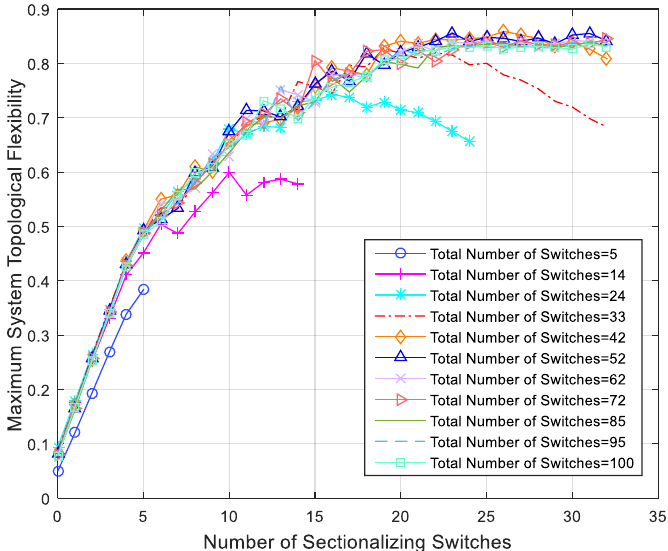
Figure 10. Maximum system topological flexibility in allocations with the different total number of switches.